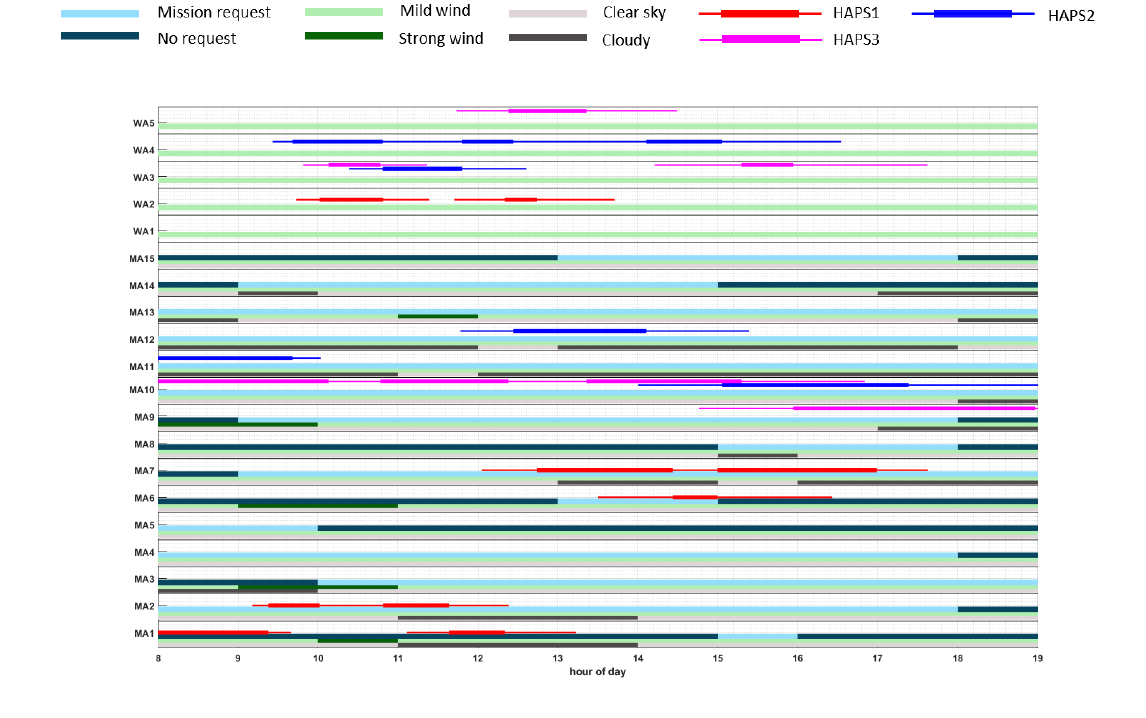
Figure 14. Illustrative example of the feasible MA-level plan with largest OF rew obtained by PC1 for the third scenario